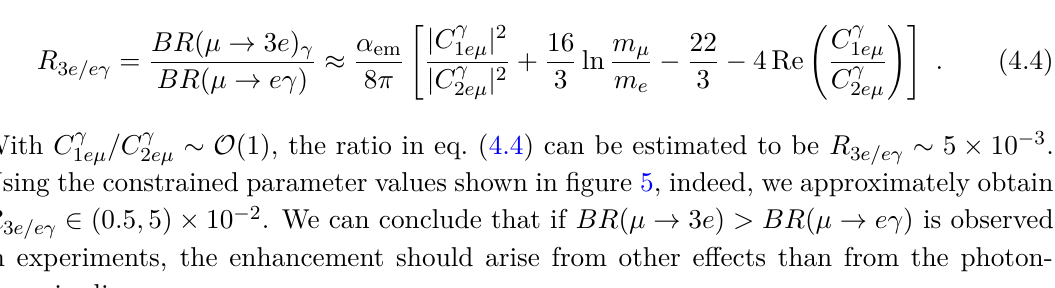
Figure 6 . (a) and (b) BR ( µ → eγ ) (in units of 10 − 13 ) as a function of | y ie y ∗ µ − e conversion rate as a function of | y 1 e y ∗ CR ( µ − e, Ti) , where the dashed lines are the sensitivities of currently ongoing experiments. The black and red points denote the results of NO and IO,